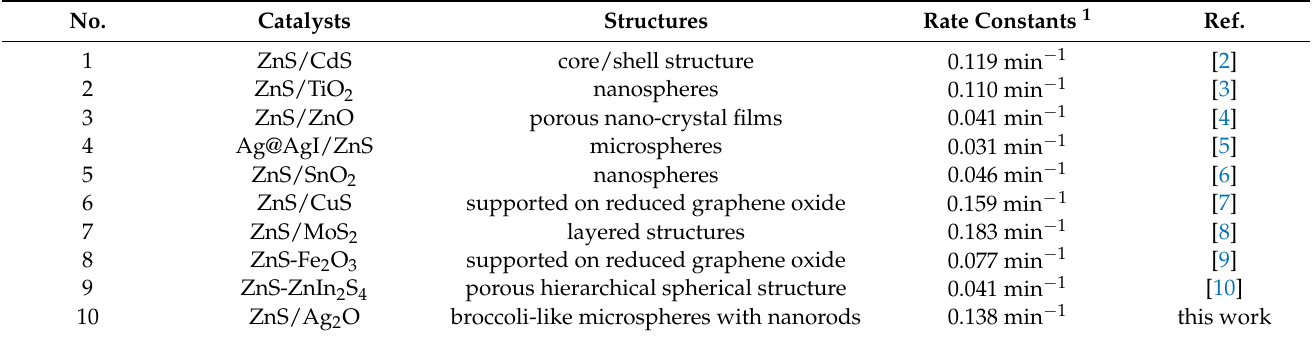
Table 1. A series of representative ZnS-based photocatalysts in various structures and corresponding catalytic rate constants in the reaction of degrading MB.